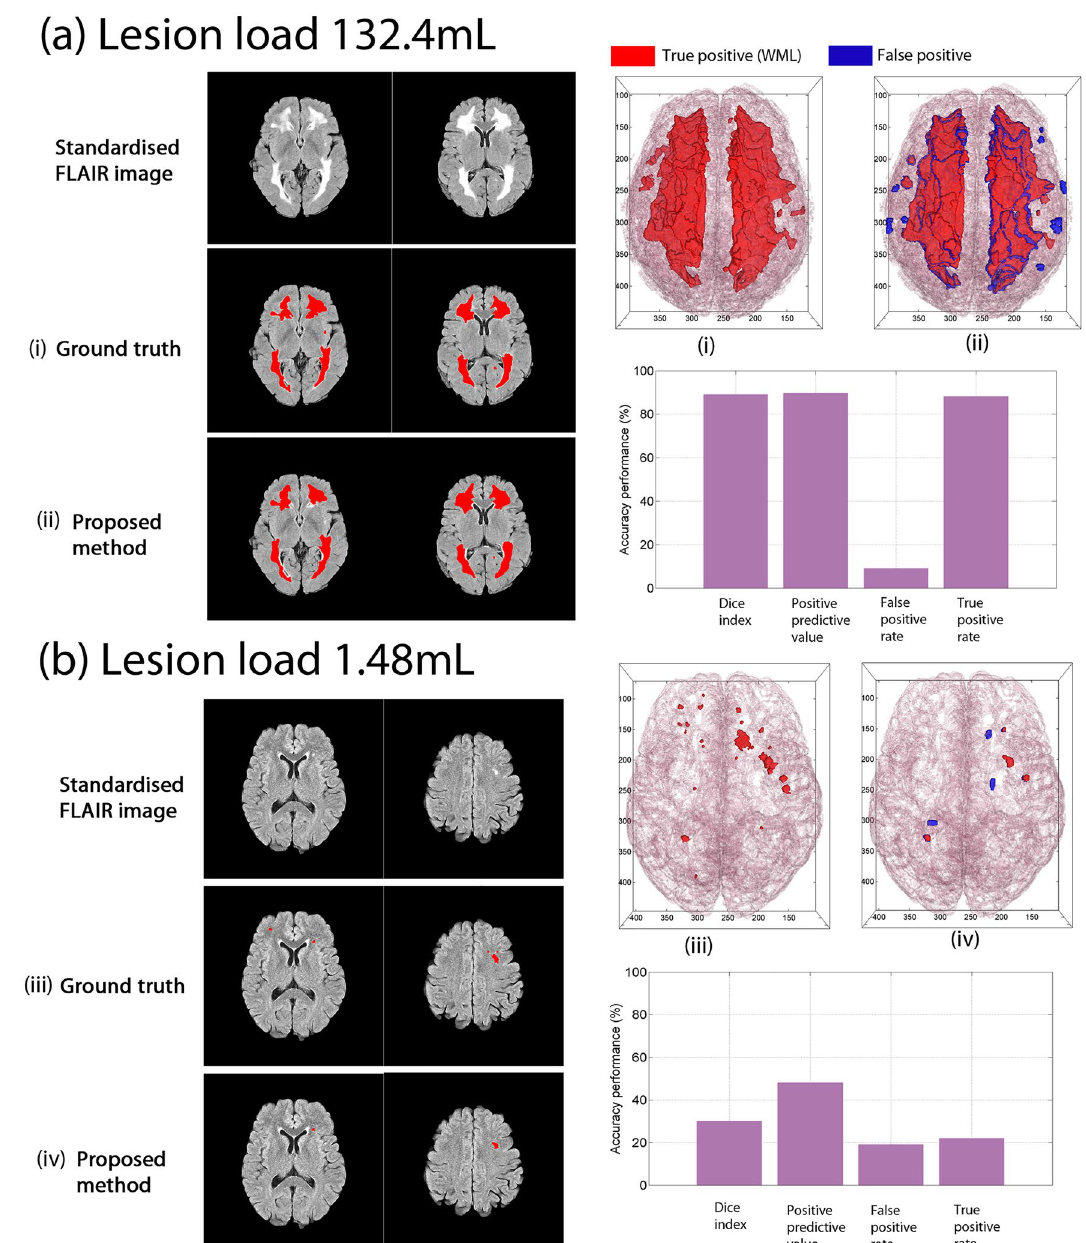
Figure 3. Comparison of the proposed method to ground truth for severe and mild cases. Representative examples of the performance of the proposed WML detection and segmentation are shown, with several slices of a WML binary image results segmented by a neuroradiologist and segmented by the proposed method superimposed on top of the intensity standardised FLAIR image. The binary image data of white matter and white matter lesions were also used for three-dimensional reconstruction. ( a ) For severe cases, the results of both are very close. ( b ) The results of mild cases show greater discrepancy, which is also the challenge of the proposed method and other comparative methods for mild